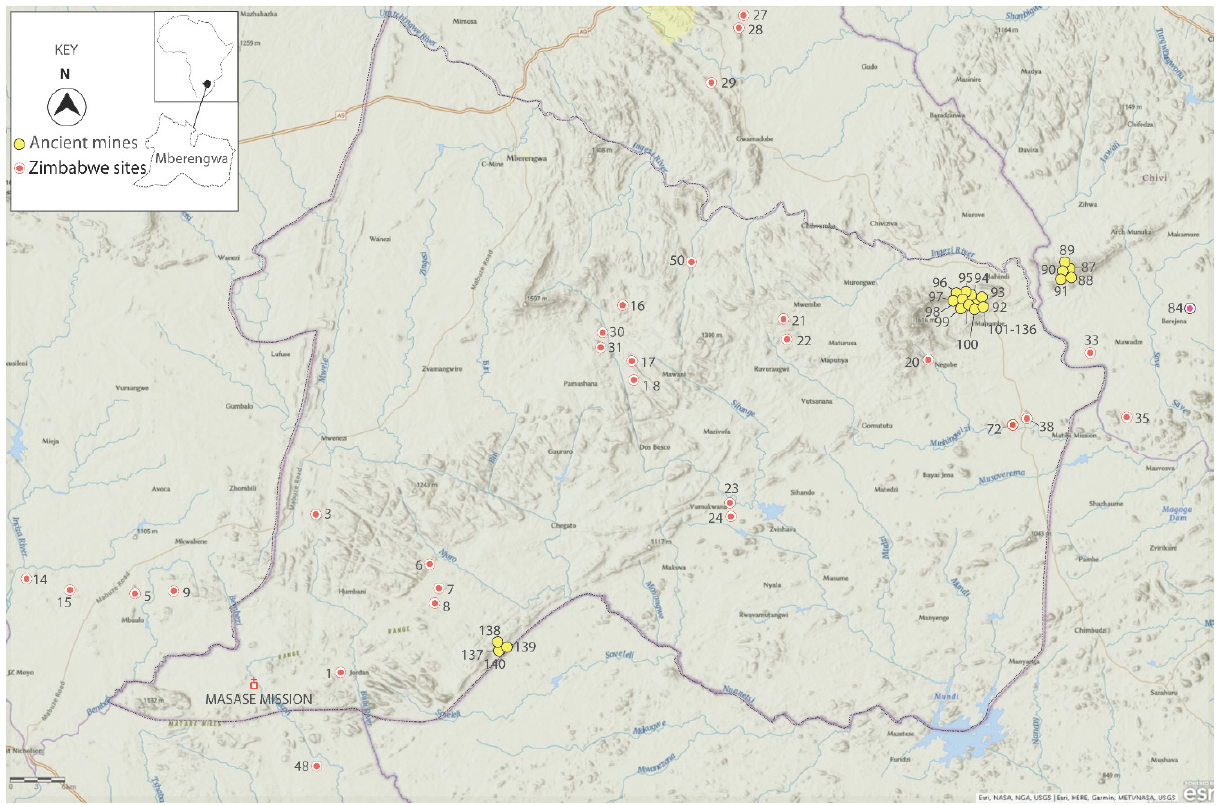
Figure 2. Distribution of some Zimbabwe tradition sites and ancient mines in and around Mberengwa.